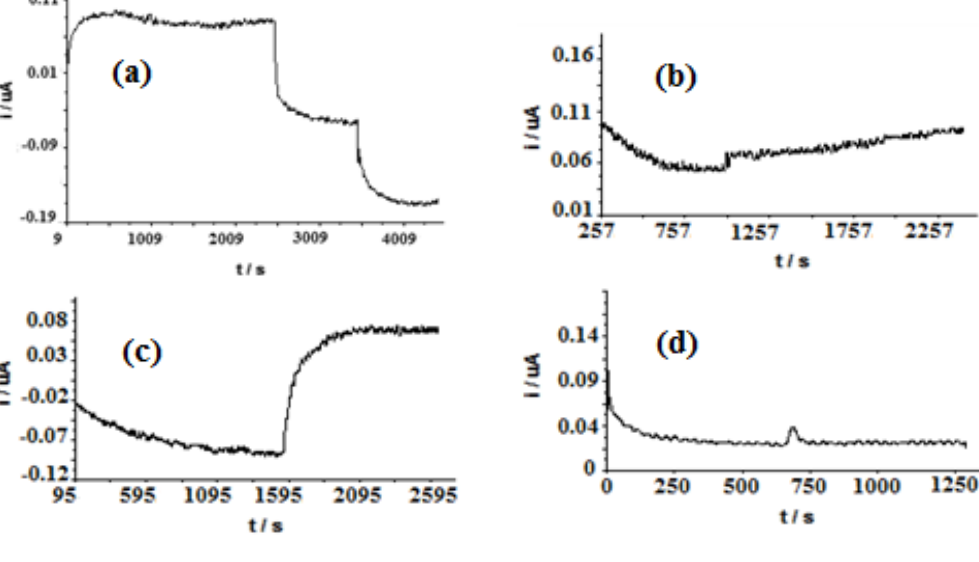
O ( a ); 196.1 µM 2 2 O ( c ) and an electrode 2 2 O ( d ). All test solutions were 2 2